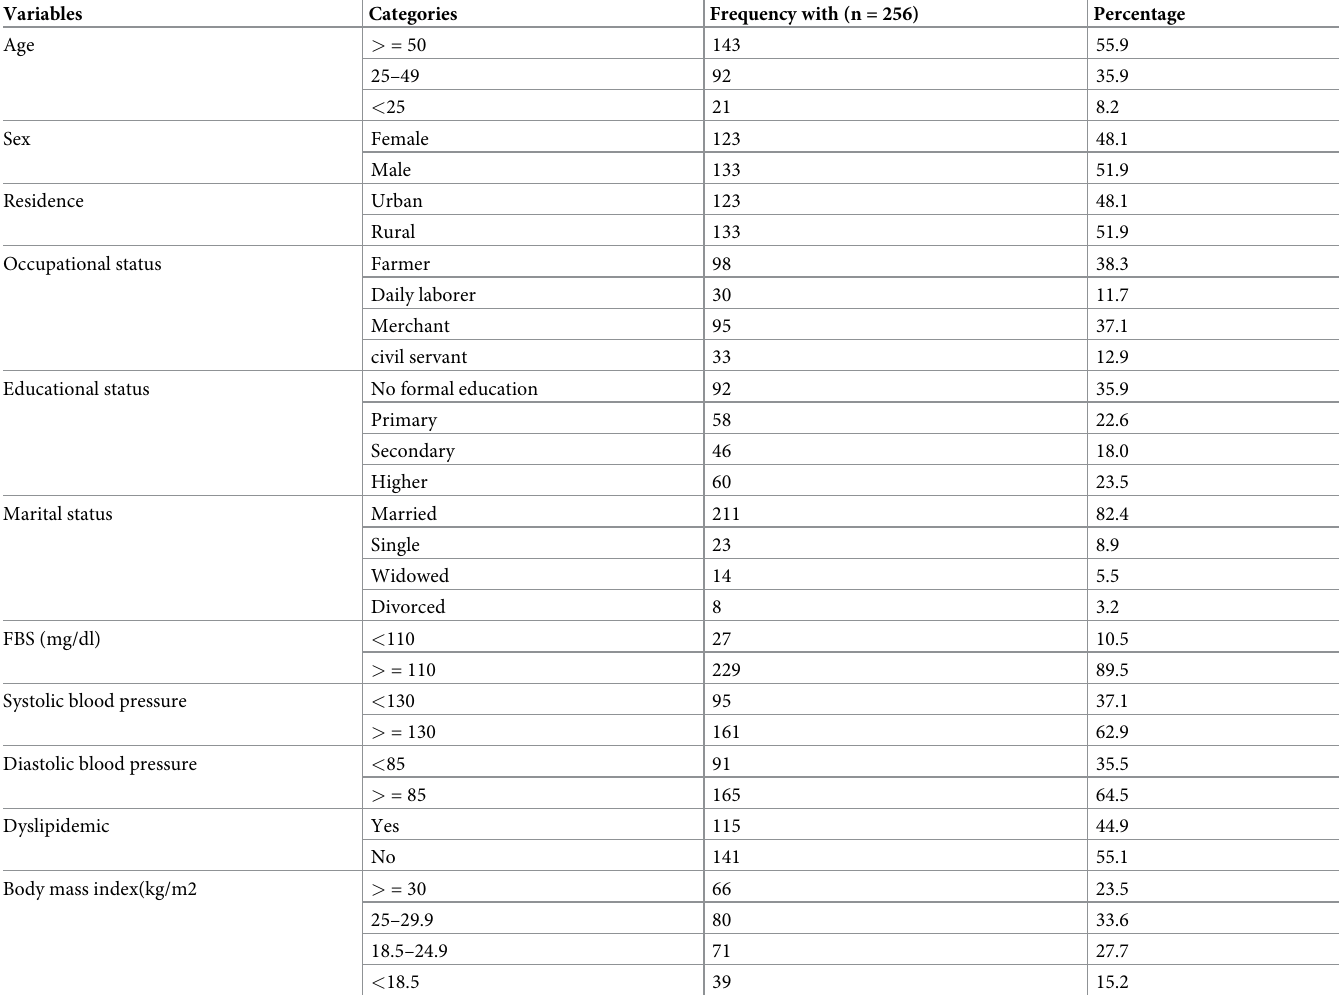
Table 1. Distribution of Socio-demographic, anthropometric and clinical characteristics among patients admitted to medical ward with metabolic syndromes, in Jimma Medical Center, South west Ethiopia from April-May